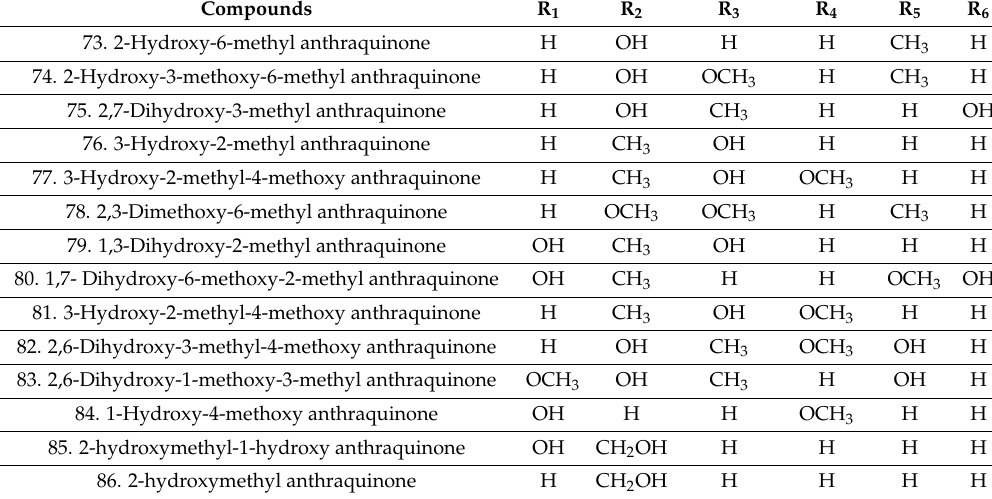
Figure 3. Chemical structures of anthraquinones in H. diffusa .